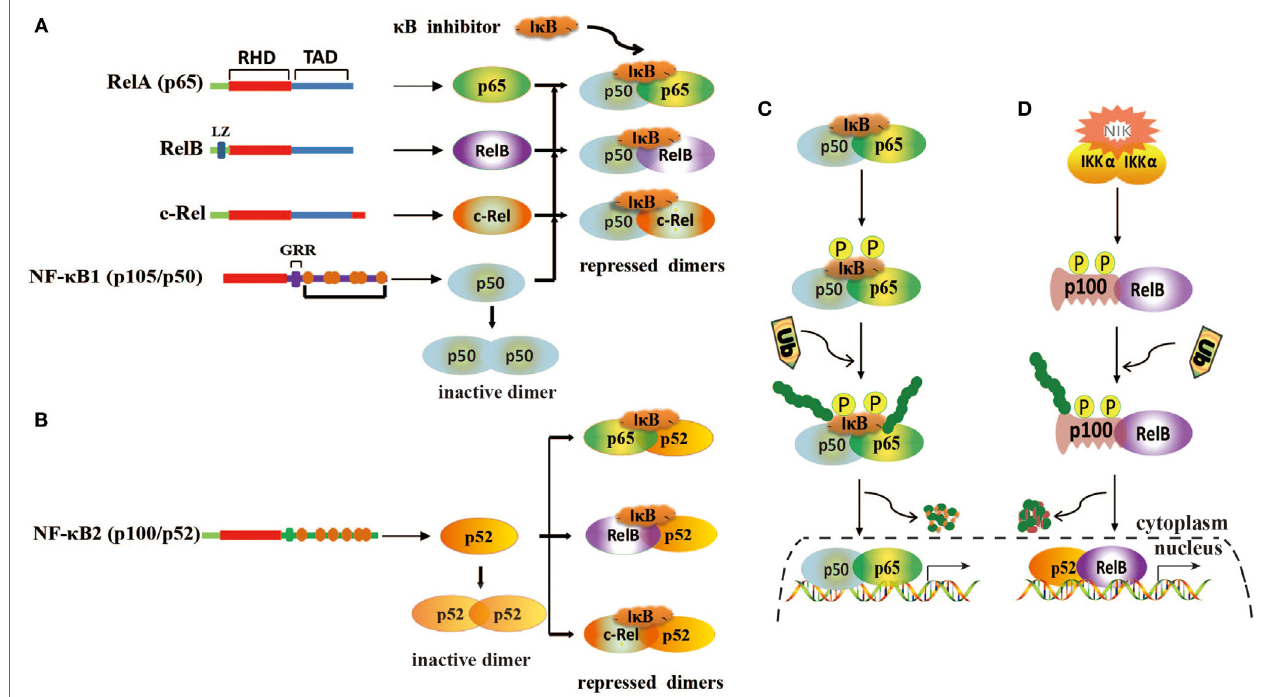
FigURe 1 | Structure of nuclear factor kappa B (NF- κ B) and its activation mechanisms. (A) Homodimerization and heterodimerization of NF- κ B1. Homodimer p50 lacks transcriptional activation domains and is unable to bind to DNA. Heterodimers are repressed by I κ B. (B) Homodimerization and heterodimerization of NF- κ B2. Homodimer p52 lacks transcriptional activation domains and is unable to bind to DNA. Heterodimers are repressed by I κ B. (C) Classical pathway of NF- κ B activation. This pathway is mediated by I κ B kinase complex (IKK), leading to phosphorylation and degradation of I κ B. (D) Alternative pathway of NF- κ B activation. This pathway involves IKK α activation via NF- κ B-inducing kinase (NIK) and induces the phosphorylation of p100, leading to the generation and translocation of